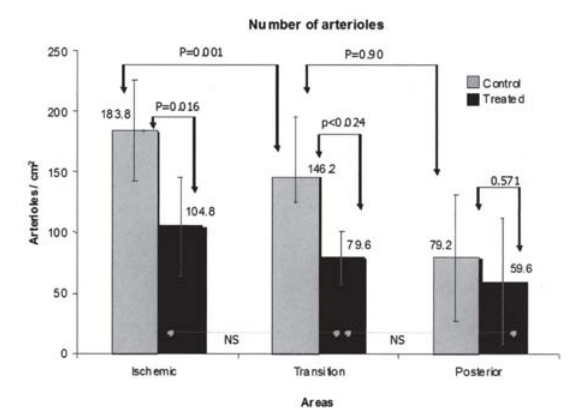
Fig. 4 - Comparison between the number of arterioles/cm 2 ; in control and treated groups. NS, non significant. Student’s t test between each two samples, for expression of differences between areas and